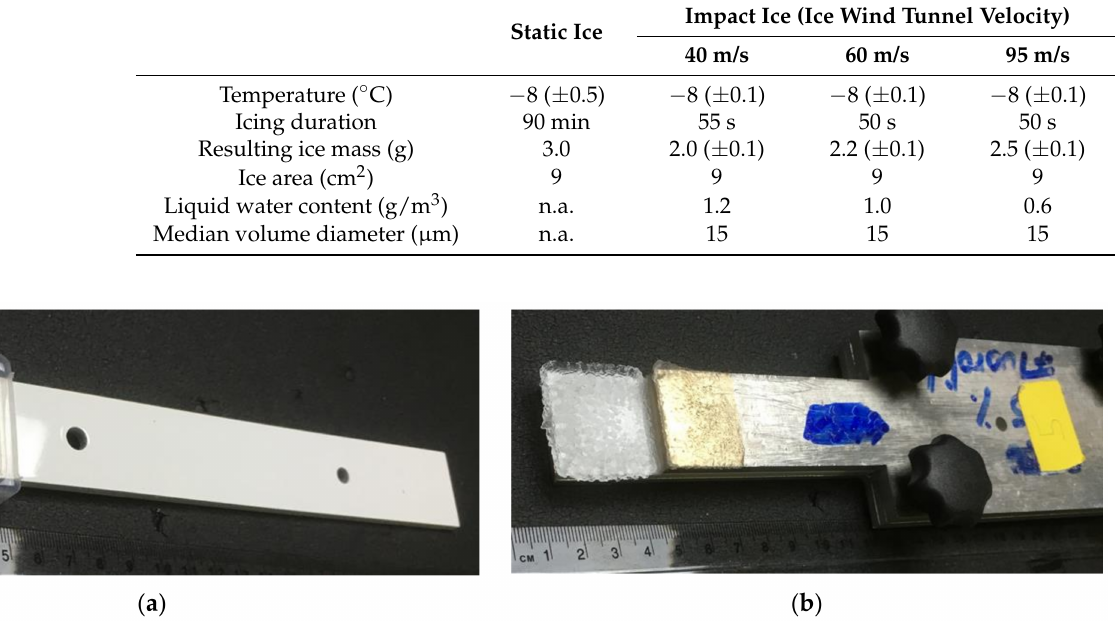
Figure 2. Test sample preparation with: ( a ) a silicone mold for static ice; ( b ) specimen holder for ice wind tunnel insertion for impact ice